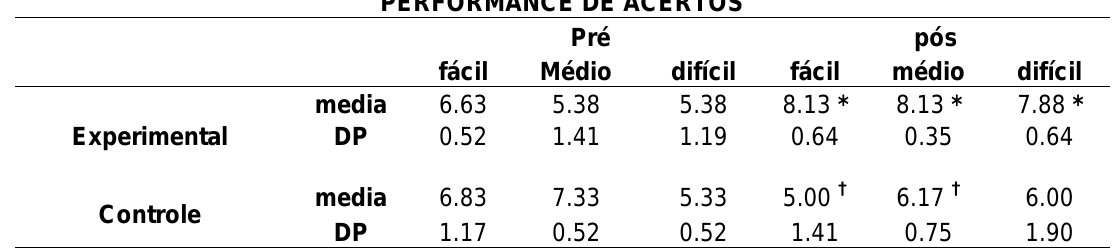
Tabela 1. Performance específica de acertos. Verifica-se as performances de acerto nos níveis fácil médio e difícil. (*) Indica aumento da performance no grupo experimental quando comparado ao momento pré (p<0.05). (†) Indica diminuição da performance no grupo controle quando comparado a o momento pré (p<0.05).